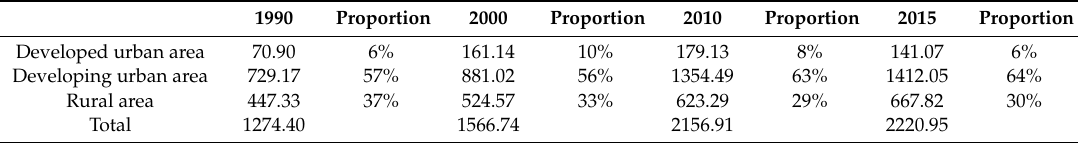
Figure 2. ( a ) Processes of urban expansion from 1992–2018 (different colors represent regions where the DN values were 50 or greater, indicating urban expansion.), ( b ) Areas with different levels of urbanization (see Table 1 for the division basis). Table 3. Population of areas with different urbanization levels (Unit: ten thousand).